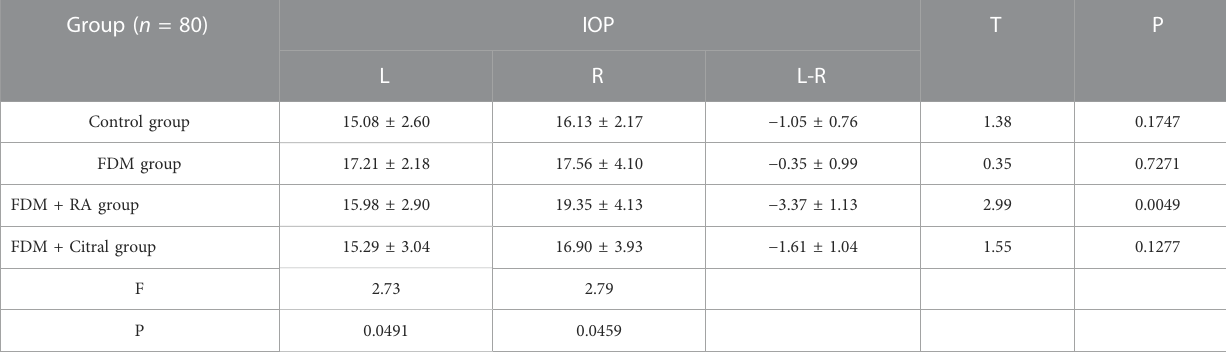
TABLE 3 IOP results of left and right eyes of guinea pigs in each group (mmHg). Group ( n =